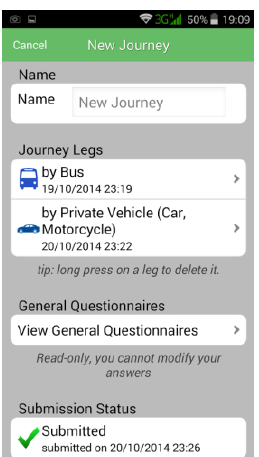
Figure 1. a) Snapshot of navigation app interface b) Snapshot of Game app interface